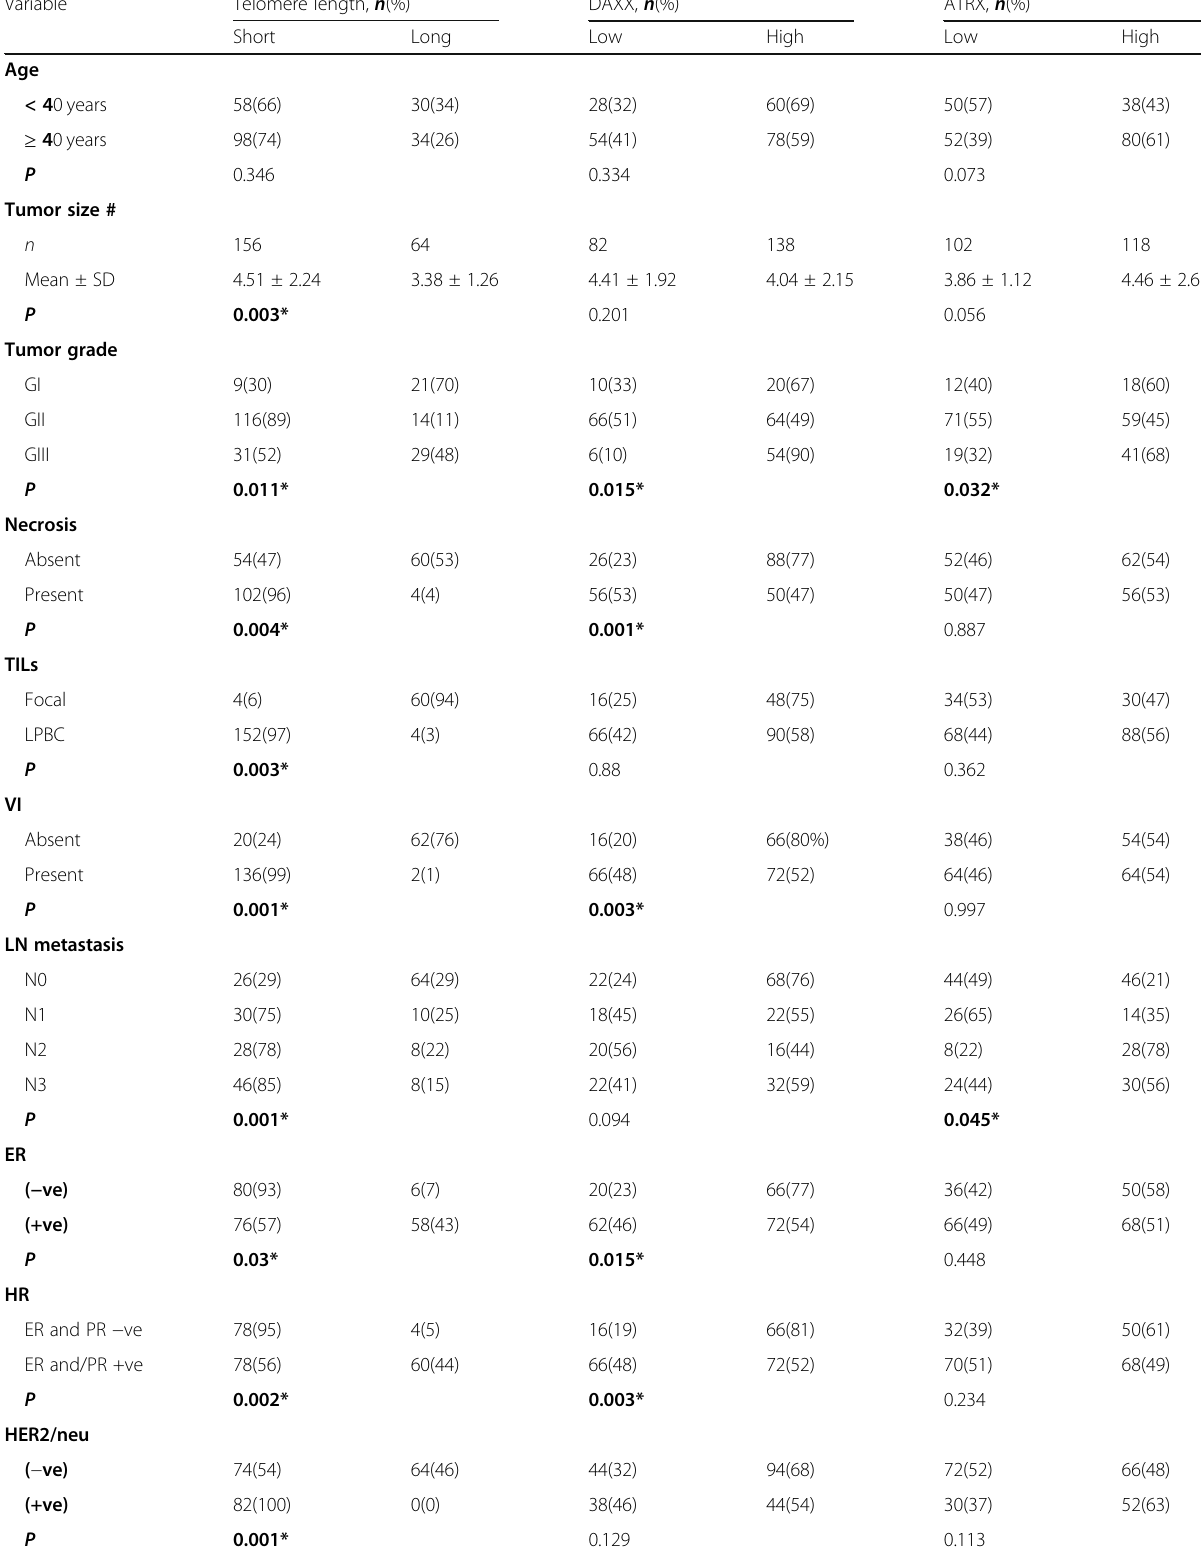
Table 4 Association of telomere length, DAXX, ATRX expression, and clinicopathological parameters